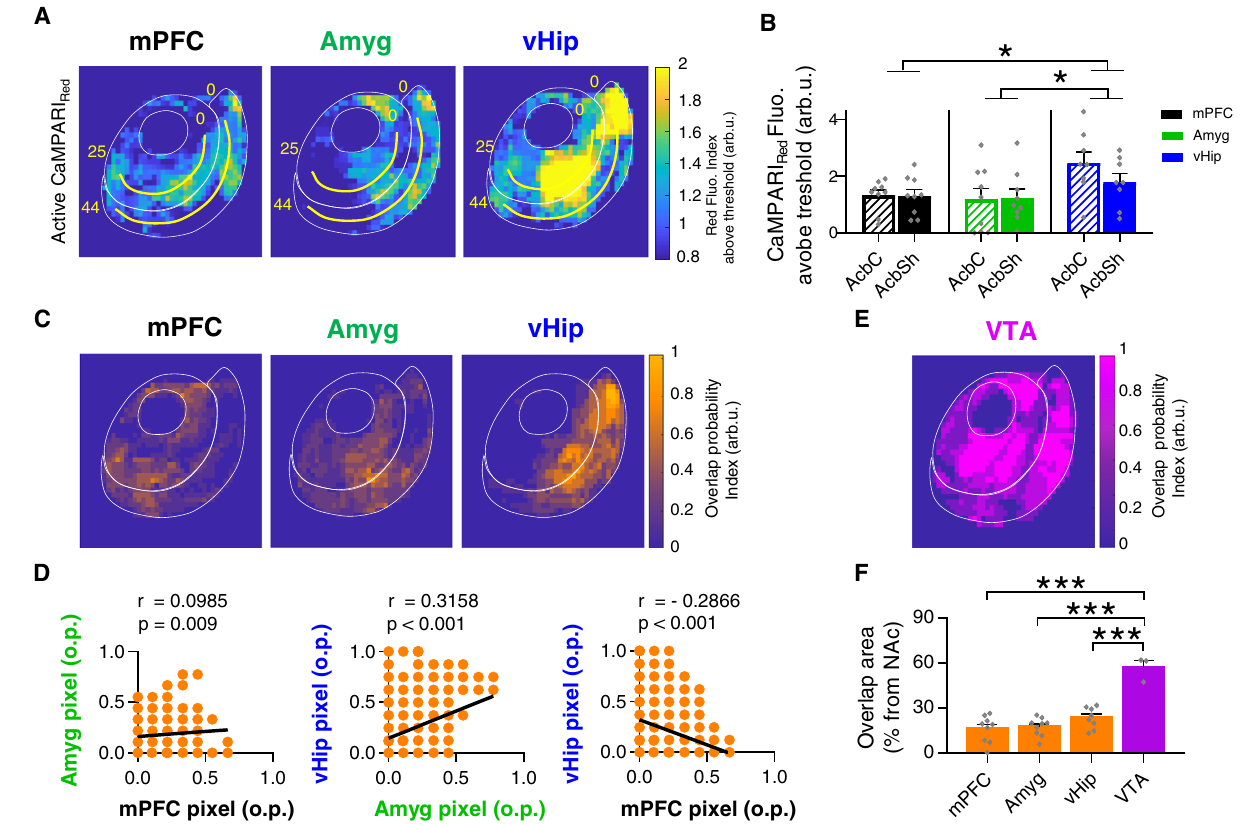
Fig. 8 | Pathway-speci fi c neuron – astrocyte circuitries in the nucleus accum- bens. A NAc spatial map of astrocytic activity above the activation threshold in response to each glutamatergic input. Yellow lines starting from pixel 0 in each subregion were used for quanti fi cation (pixel=50 µ m 2 ). B Average CaMPARI Red spatial fl uorescence (arb.u.) showing the signal above the activation threshold of thethreepathways(mPFCblack,9slices,6mice;Amyggreen,9slices,6mice;vHip blue,8slices,6mice).Two-wayANOVA,Holm – Sidaktestformultiplecomparisons; * P <0.05.Formorestatisticaldetail,seeSupplementaryTable1. C NAcspatialmaps showing overlap colocalization probability between high-density afferent regions and increased astrocytic activity for each glutamatergic input. D Spatial